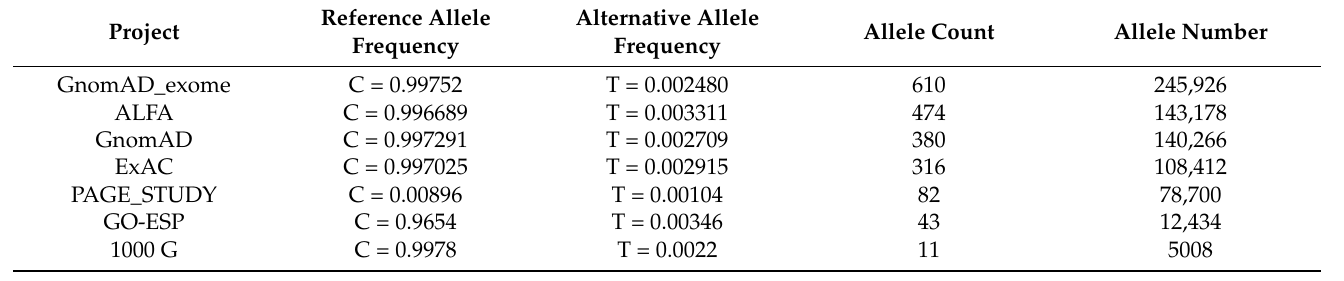
Table 1. Allele frequencies of POR P228L (DBSNP ID: rs17853284) from different genome projects. Data obtained from NCBI database.